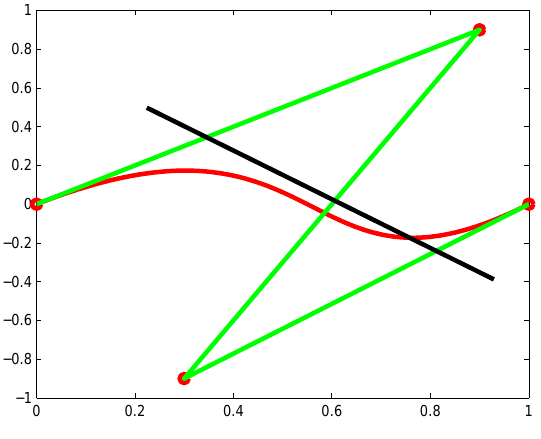
Table 329: L A TEX2 ε Latin 1 Table